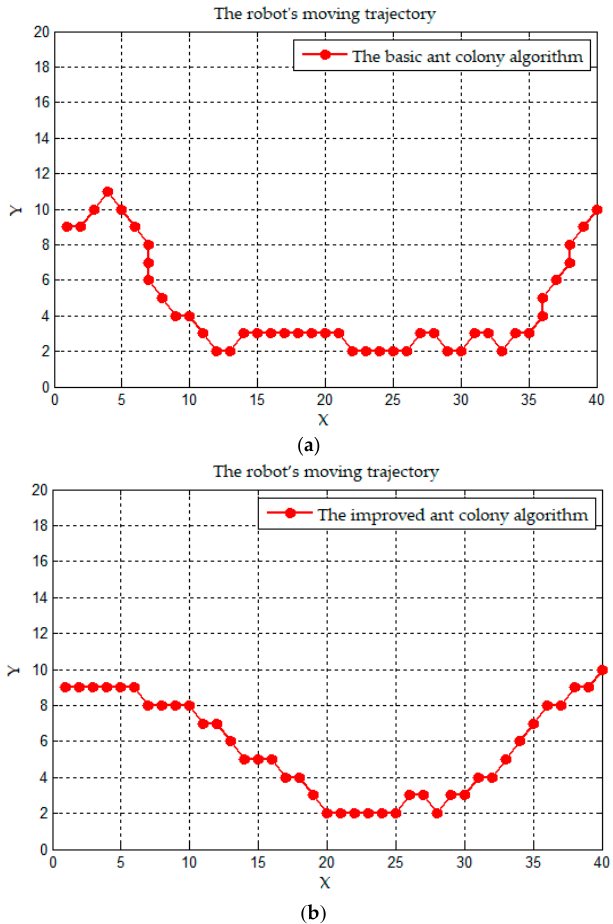
Figure 9. The continuous trajectory mapped on the plane. ( a ) A trajectory of the basic ant colony algorithm; and ( b ) a trajectory of the improved ant colony algorithm.